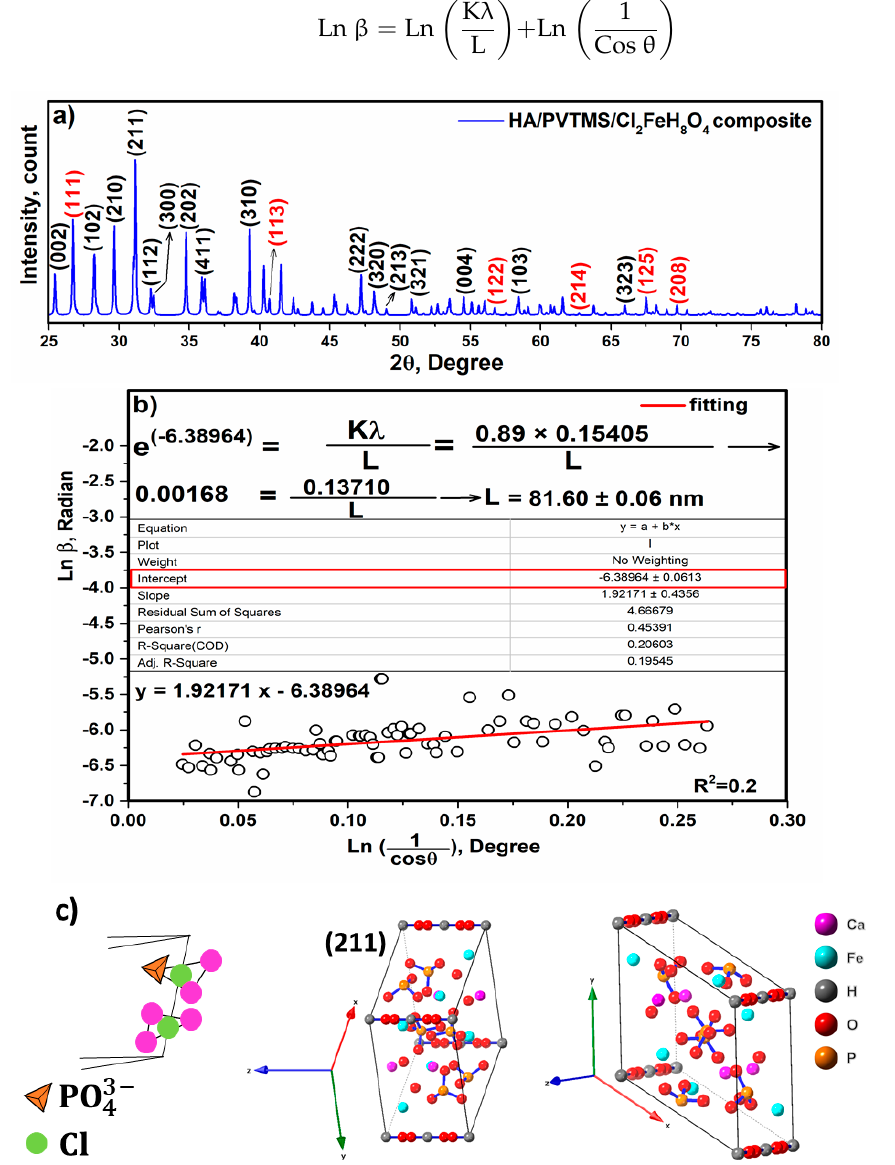
Figure 4. ( a ) X-ray diffraction, ( b ) Linear plots of the Monshi–Scherrer equation, and ( c ) cif file and the view of (211) of the